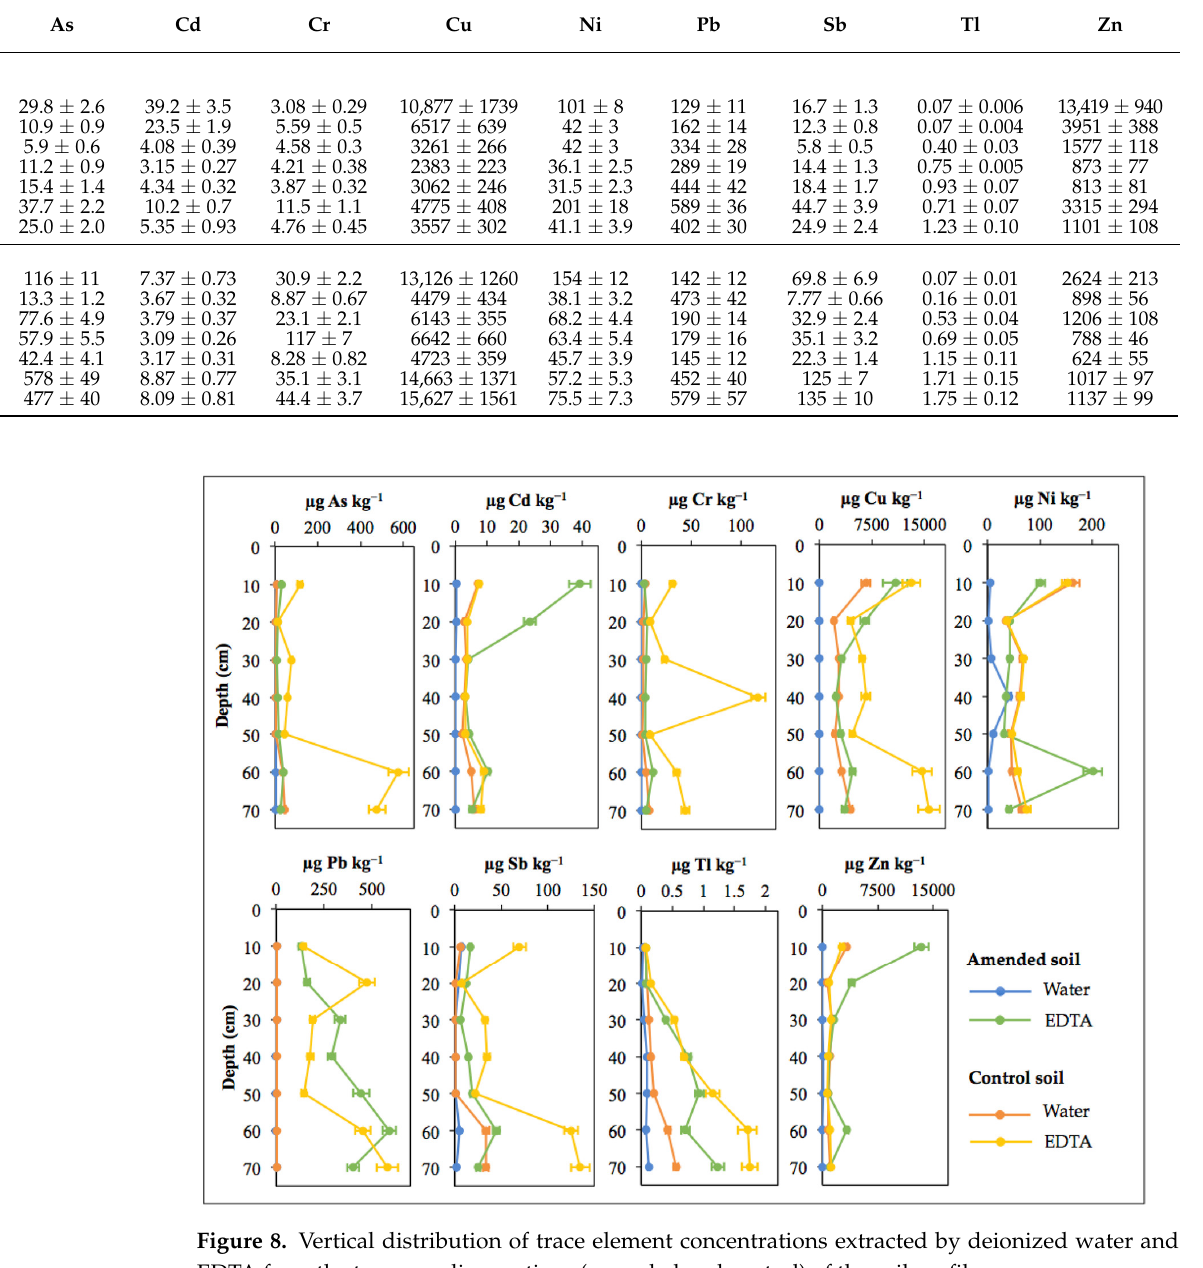
Table 5. Trace element concentrations ( µ g kg − 1 ) extracted with 0.05 mol L − 1 EDTA from amended soil and control soil samples.